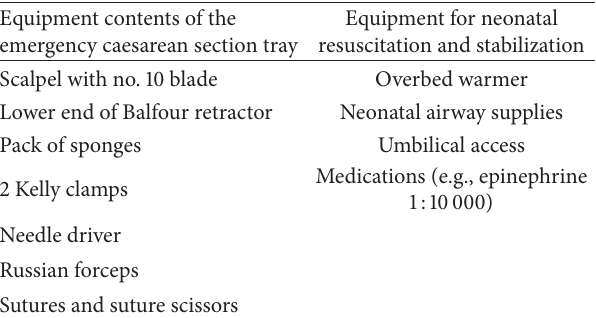
Table 1: Recommended PMCS and neonatal equipment